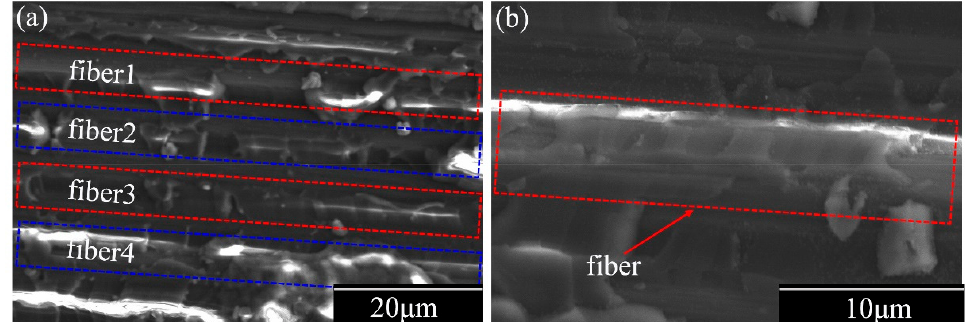
Figure 6. SEM images of the failure section of the 90° tensile damage morphology. ( a ) at the 20 μ m scale, ( b ) at the 10 μ m scale.